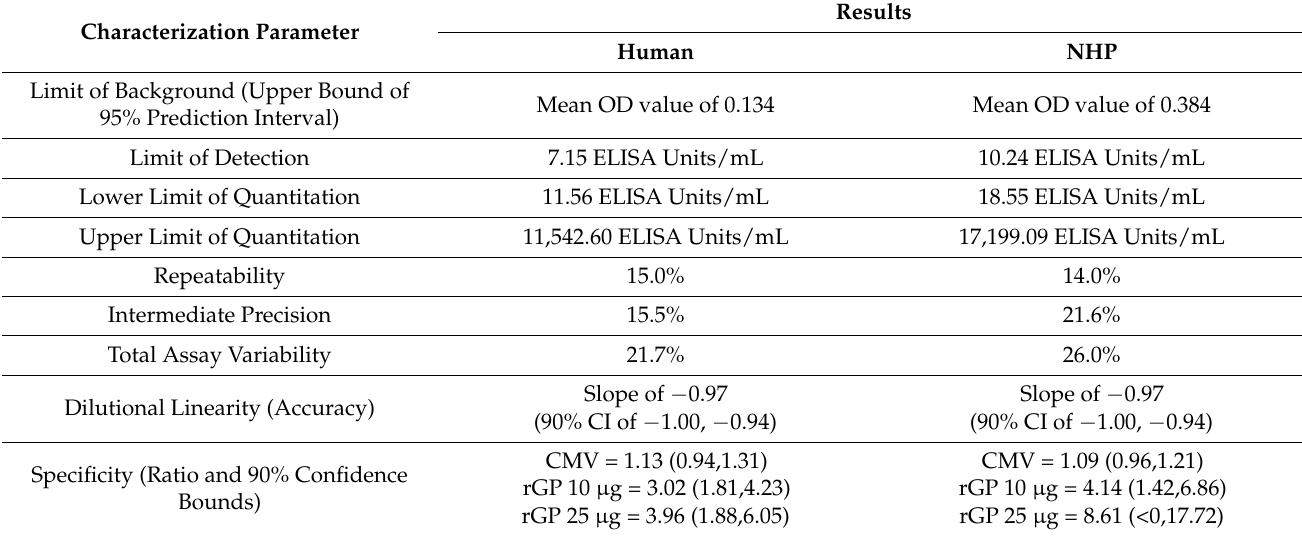
Table 3. Summary of Anti-SUDV GP IgG ELISA Qualification